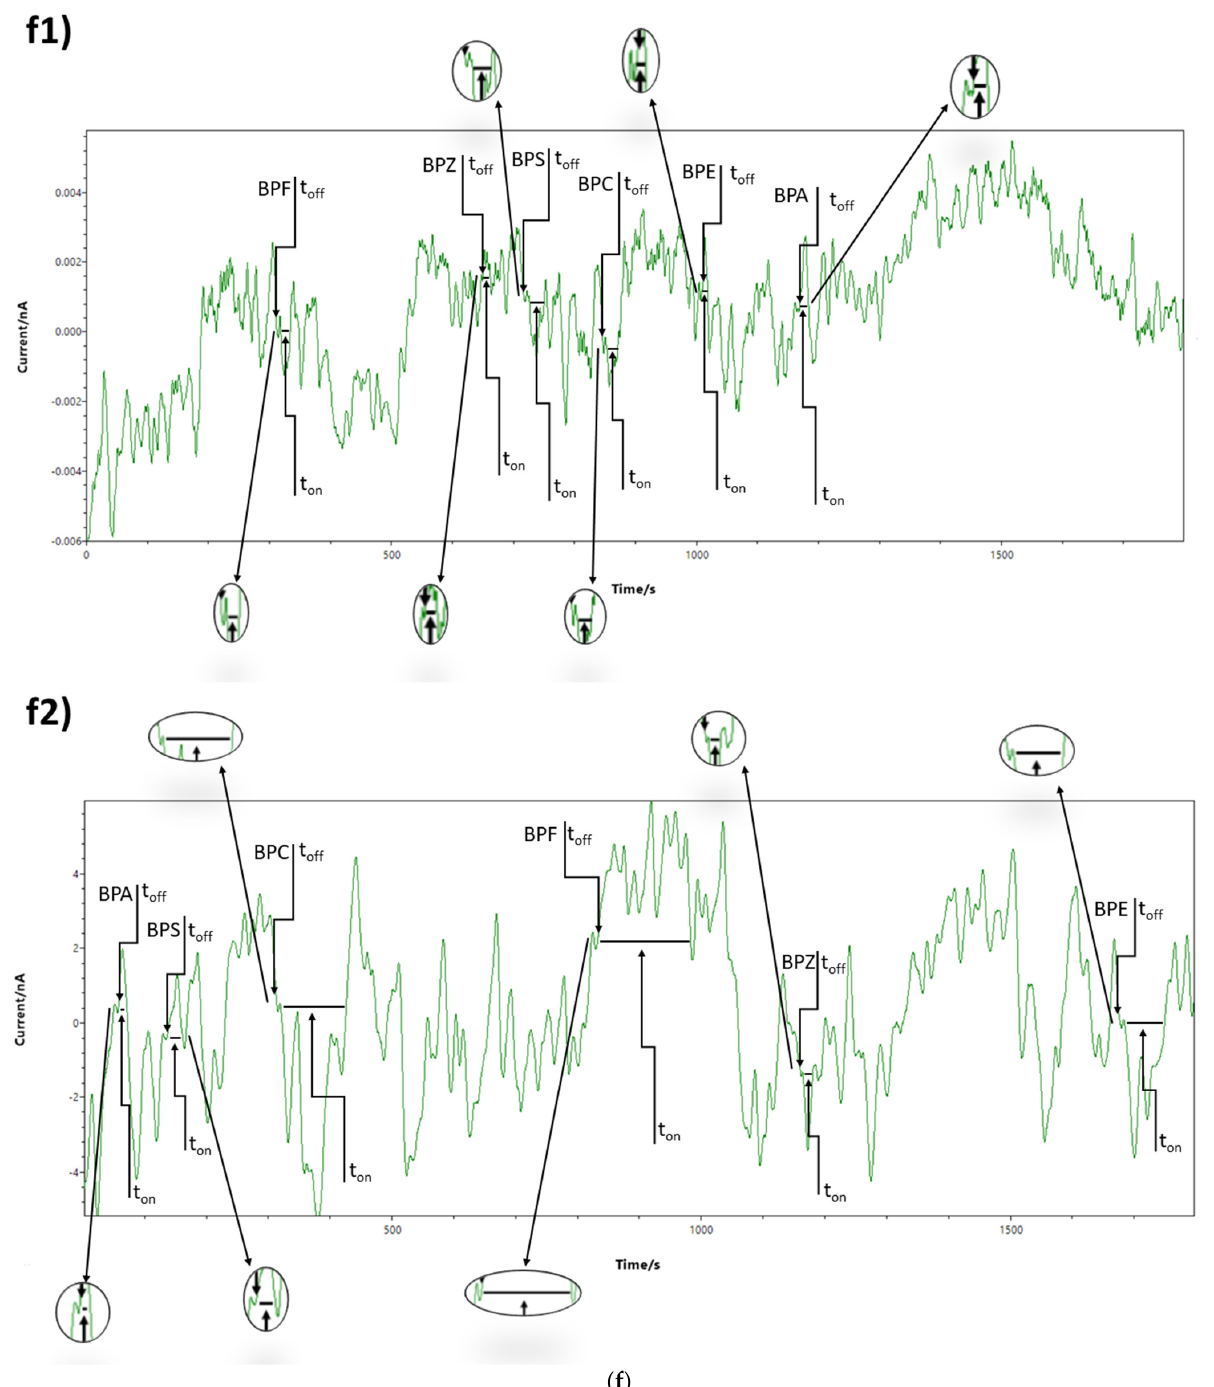
Figure 5. Examples of diagrams obtained for the determination of BPA, BPC, BPE, BPF, BPS, and BPZ in different food samples: ( a ) milk ( a1 )—in a bottle made from polypropylene with a silicon nipple; ( a2 )—in a bottle made from borosilicate glass with a silicon nipple; ( a3 )—in a bottle made from polypropylene with a latex nipple; ( a4 )—in a bottle made from borosilicate glass with a latex nipple; ( a5 )—in a bottle made from polypropylene with a silicon nipple), ( b ) canned pear ( b1 )— fruit; ( b2 )—juice, ( c ) preserved tomatoes ( c1 )—tomato; ( c2 )—juice, ( d ) tuna preserved in its own juice ( d1 )—tuna; ( d2 )—oil, ( e ) tuna preserved in its own juice and oil ( e1 )—tuna; ( e2 )—oil, and ( f ) tuna preserved in oil ( f1 )—tuna; ( f2 )—oil.